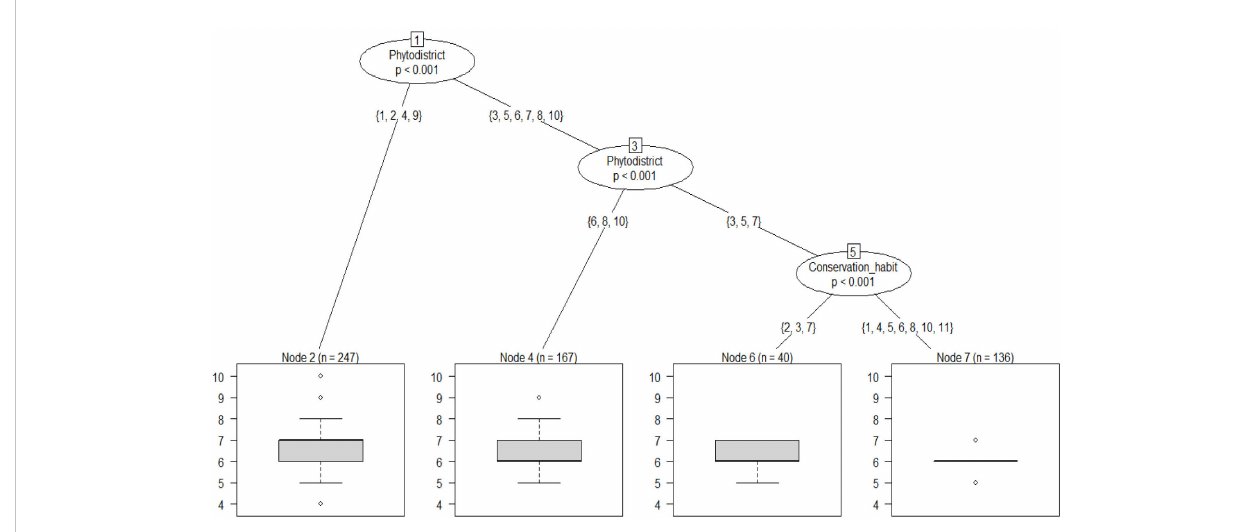
FIGURE 7 Effects of social and plant ecological factors on ethnomedicinal knowledge. Legend: phytodistricts. 1: Co ̂ tier; 2: Pobè; 3: Oueme Valley; 4: Plateau; 5: Zou; 6: South Borgou; 7: Bassila; 8: North Borgou; 9: Atacora Chain; 10: Me ́ krou-Pendjari. conservation habitat. 1: forest; 2: fallow; 3: farm; 4: home; 5: fallow and forest; 6: forest and home; 7: fallow and home; 8: farm and home; 10: home, forest, and fallow; 11: farm, fallow, and